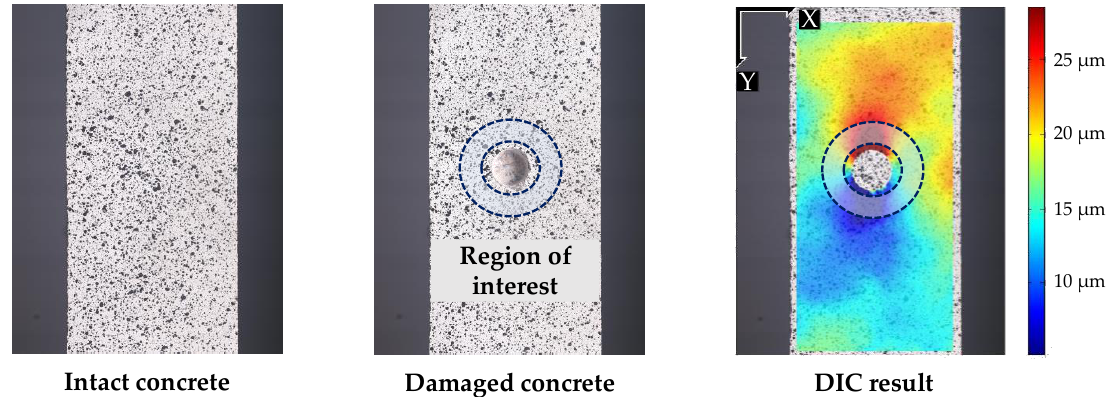
Figure 3. Displacement field from DIC using the two images before and after hole-drilling.